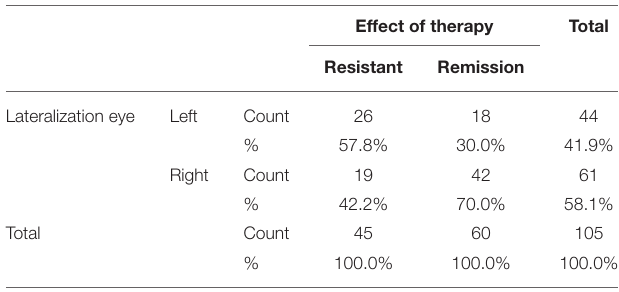
TABLE 3 | Relationship between functional lateralization of the eye and the effectiveness of therapy.